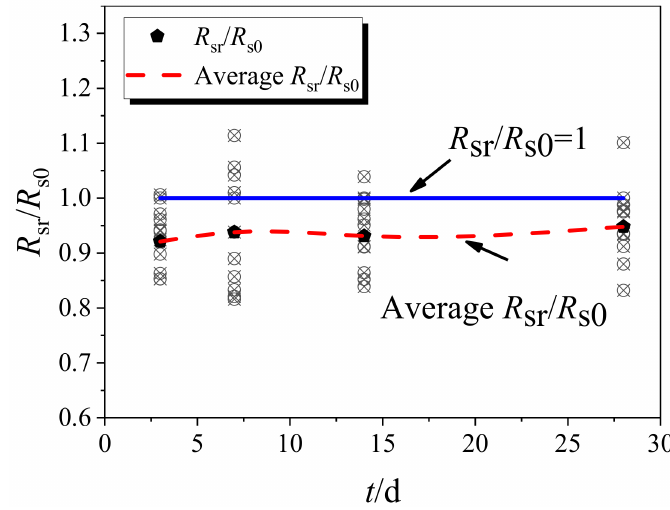
Figure 9. The proportion of residual strength at different